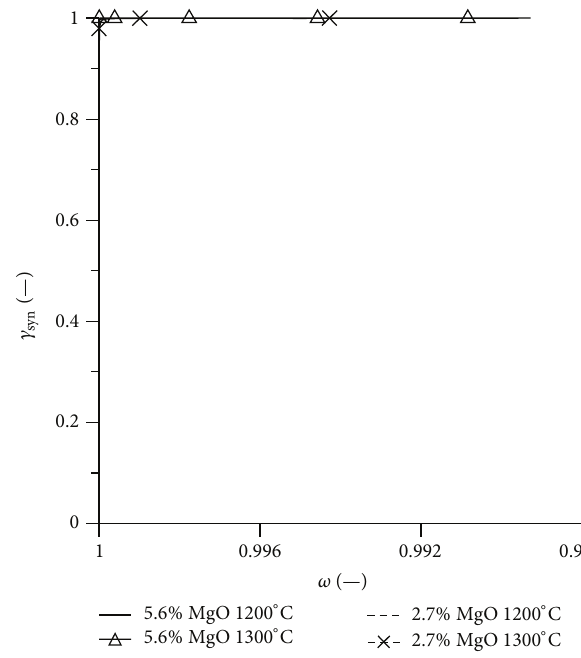
Figure 7: Dry gas concentration profile of the second syngas cycle at 950 ∘ C for the 5.6% MgO 1300 sample.